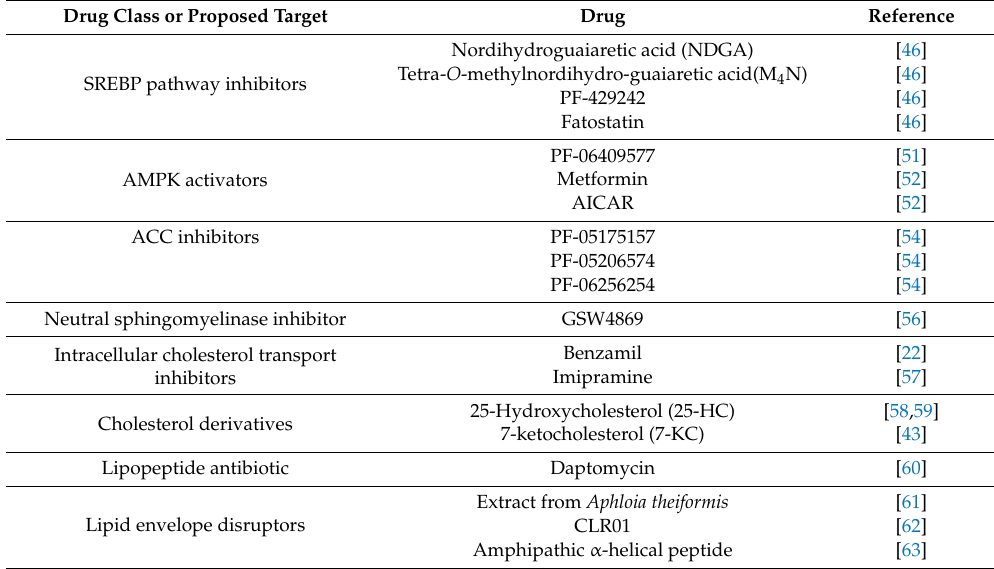
Table 1. Examples of some pharmacological inhibitors of ZIKV-infection related to lipid metabolism and